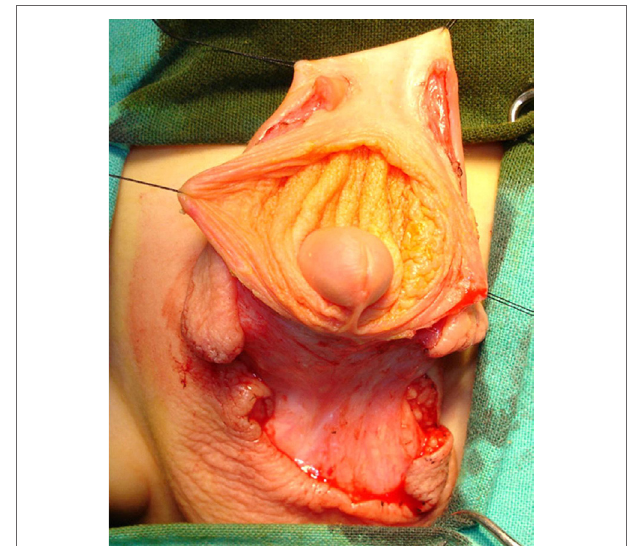
FigUre 1 | Megaprepuce in a young infant with a non-scarred preputial